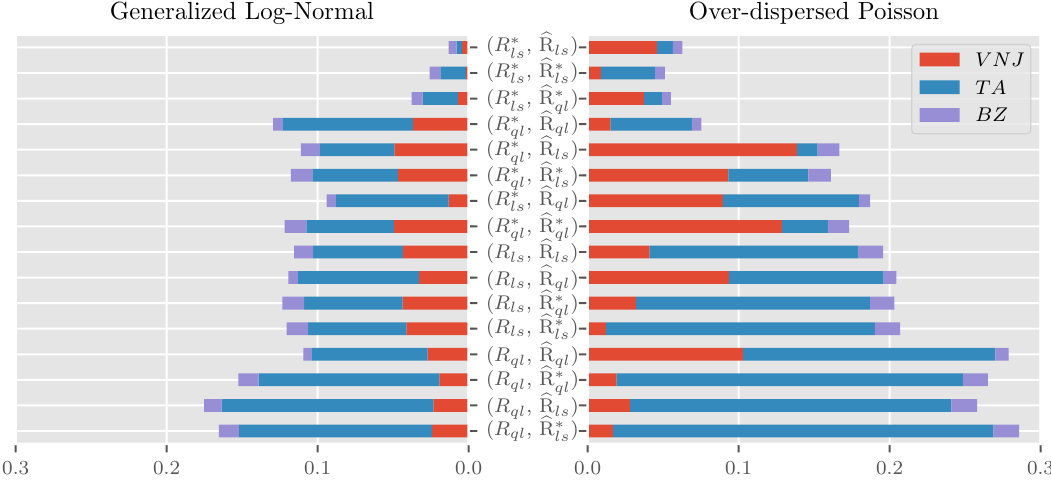
Figure A1. Bar chart of maximum absolute errors for the considered combinations of R and